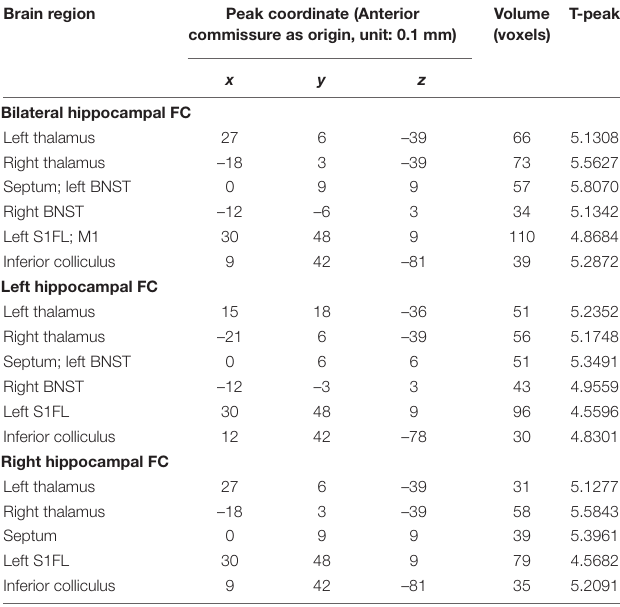
TABLE 1 | FC analysis selecting the hippocampus as the